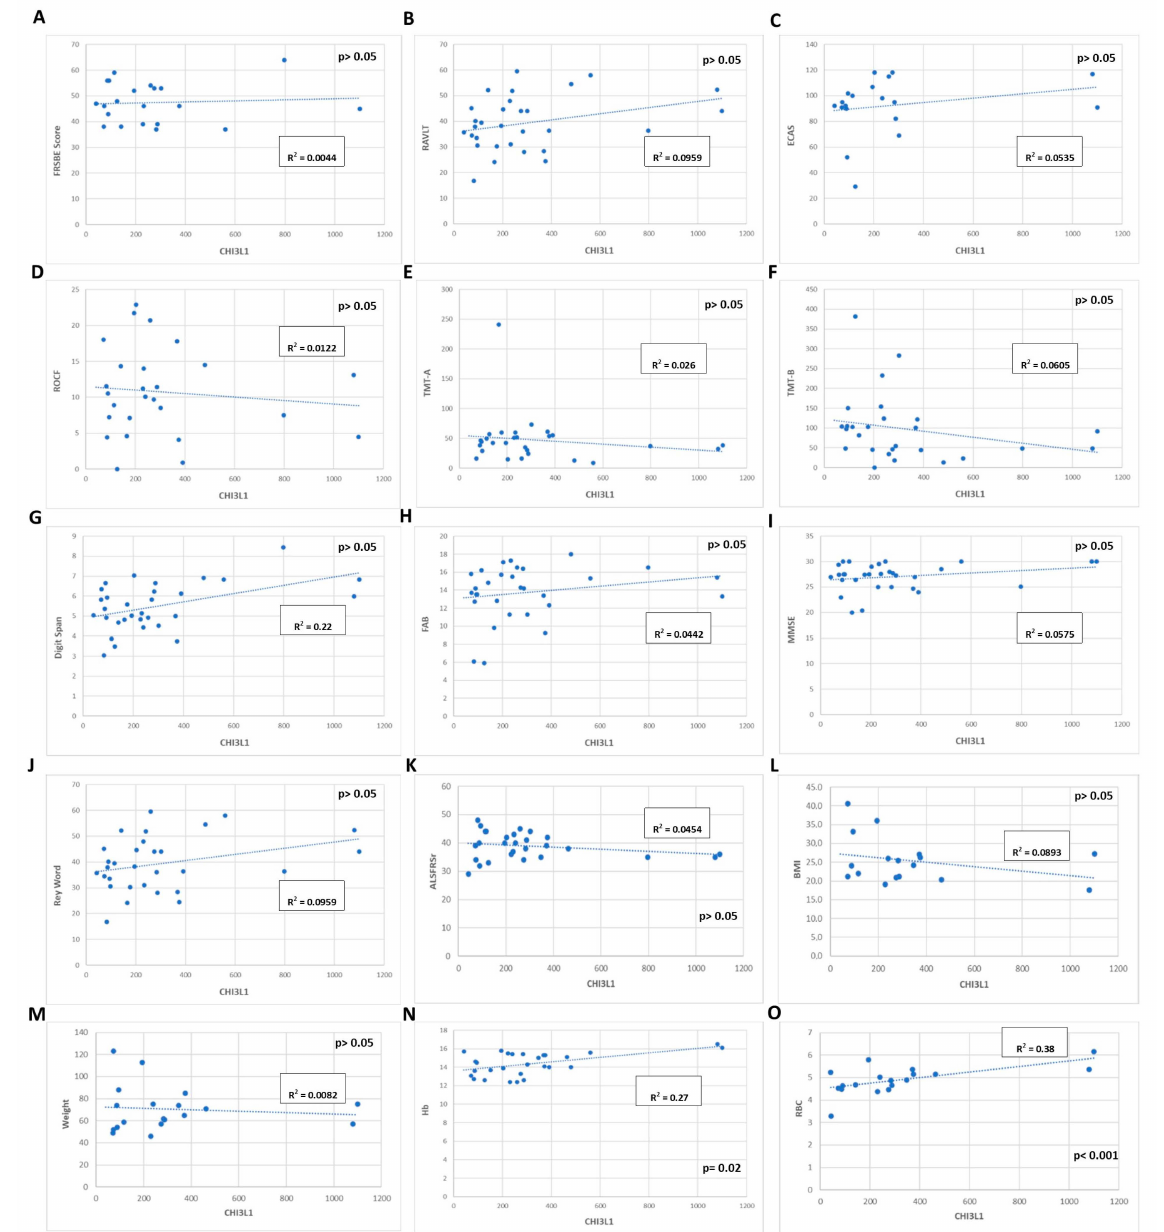
Figure 2. Correlation between CHI3L1 plasmatic levels and clinical, neuropsychological, and laboratory data in MND patients. We did not observe any statistical correlation ( p > 0,05) between CHI3L1 plasmatic levels and any neuropsychological test ( A – J ), ALSFRSr scale ( K ), weight, or BMI ( L , M ). The only correlation we identified is between CHI3L1 plasmatic levels and haemoglobin ( N ), and CHI3L1 plasmatic levels and red blood cells ( O ). ALSFRSr: ALS Functional Rating Scale revised; Hb: haemoglobin; RBC: red blood cells; FRSBE: Frontal Systems Behavior Scale; RAVLT: Rey Auditory Verbal Learning Test; ECAS: Edinburgh Cognitive and Behavioural ALS Screen; ROCF: Rey–Osterrieth complex figure; TMT-A: Trail Making Test A; TMT-B: Trail Making Test B; FAB: Frontal Assessment Battery; MMSE: mini–mental state examination; BMI: body mass index; R: Pearson coe ffi cient.